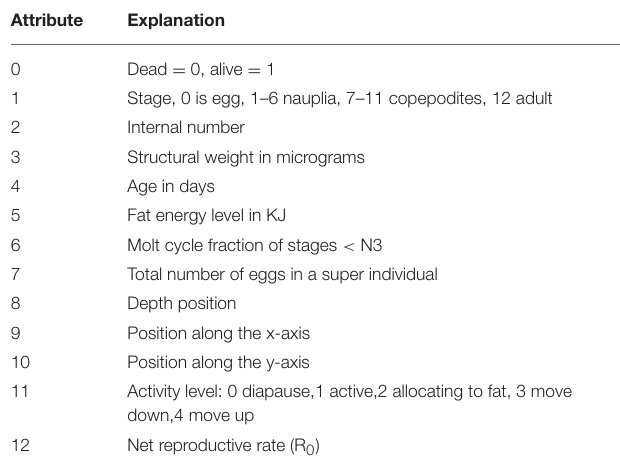
TABLE 2 | The attribute vector A s of super-individual s